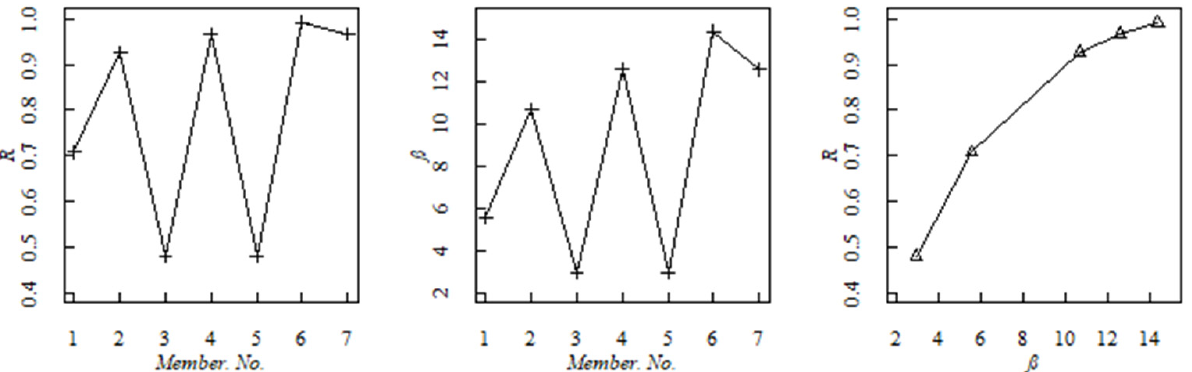
Figure 5. Structural robustness evaluation index ( R ), structural reliability index ( β ), and the fitting curve of the truss beam (Left: R vs. Member No ., middle: β vs. Member No ., and right: R vs. β ).